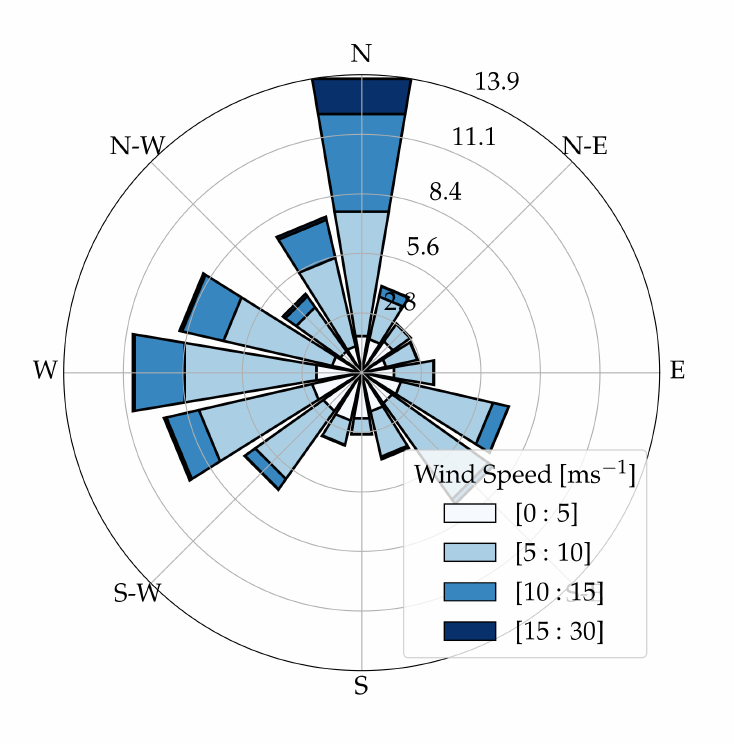
Figure 2. Distribution of the ten minute average wind measured at the on-site met masts between 1